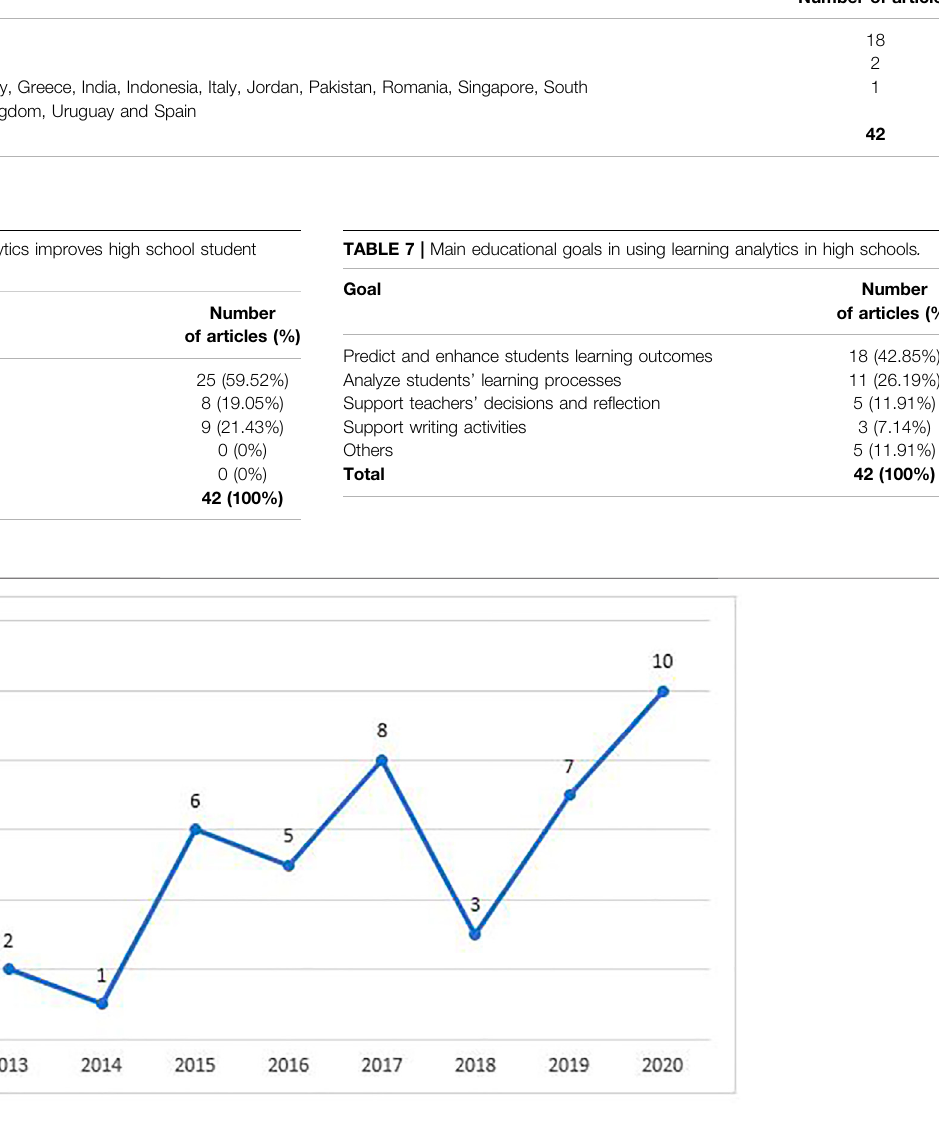
TABLE 5 | Number of articles per country . Country